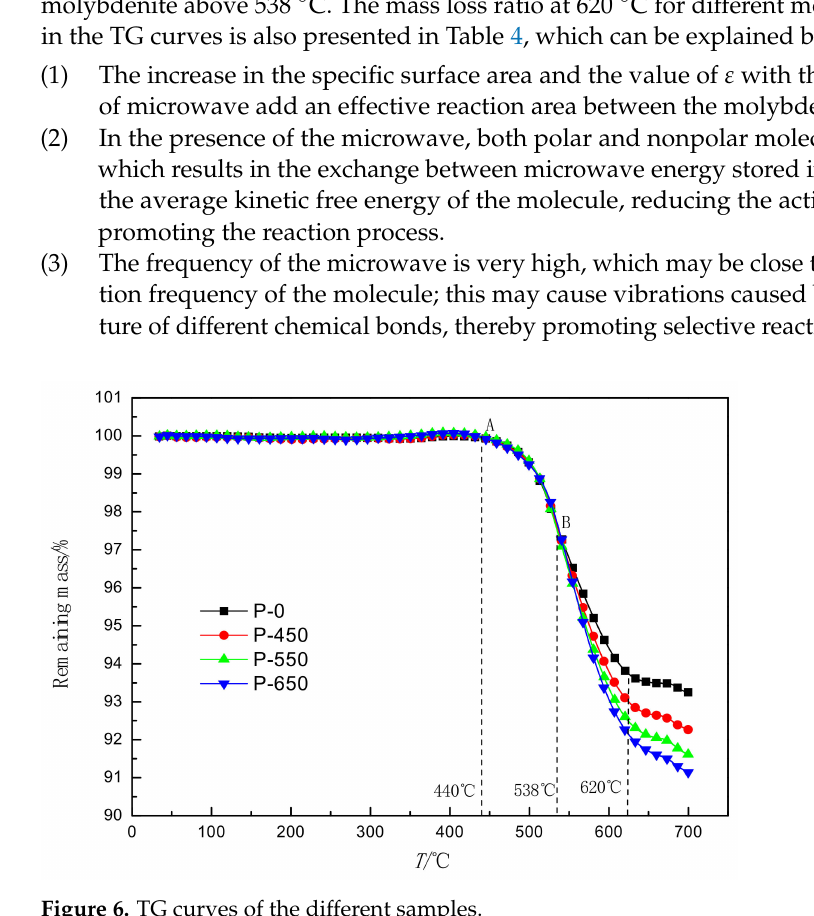
Figure 6. TG curves of the different samples. Table 4. The mass loss ratio at 620 ◦ C for different molybdenites in the TG